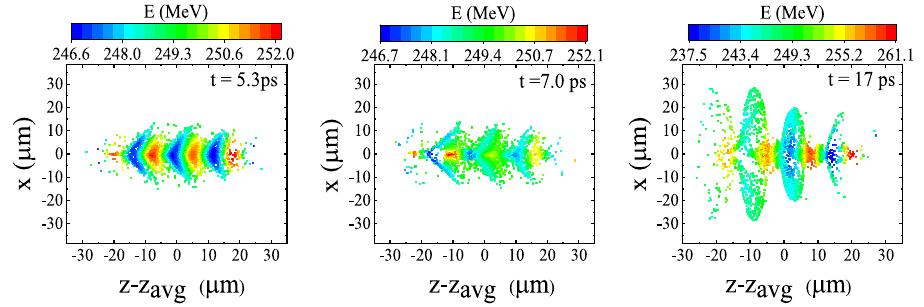
Figure 8. Snapshots of the spatial distribution of an electron beam injected with an initial energy of E 0 = 249 MeV . The other parameters are the same as in Fig. 6a.